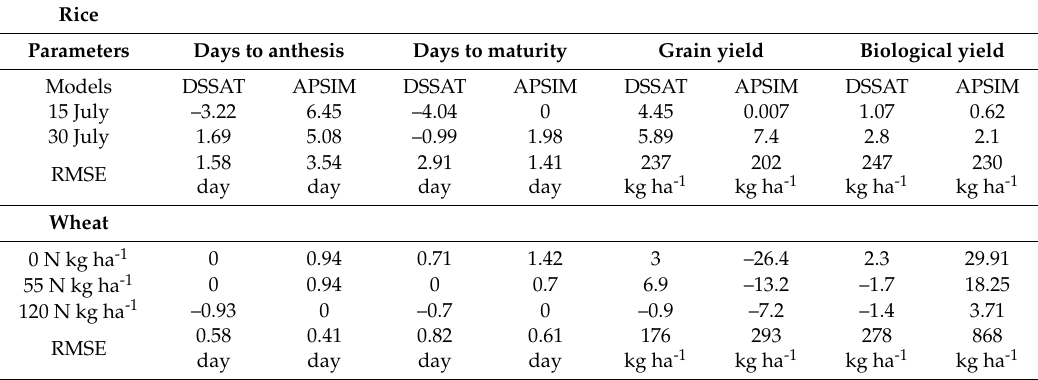
Table 4. Percent error during the evaluation of DSSAT and APSIM at various parameters using field experimental